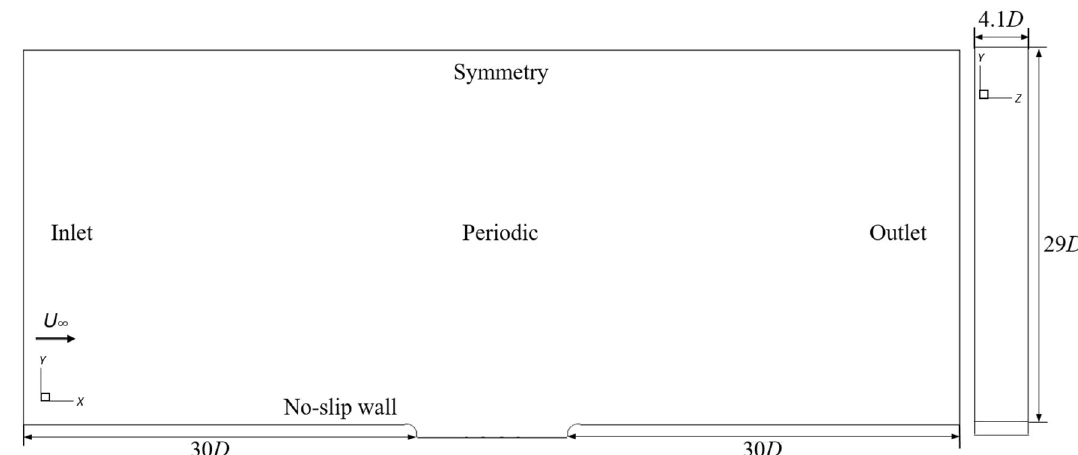
Fig. 4 Computational domain and boundary